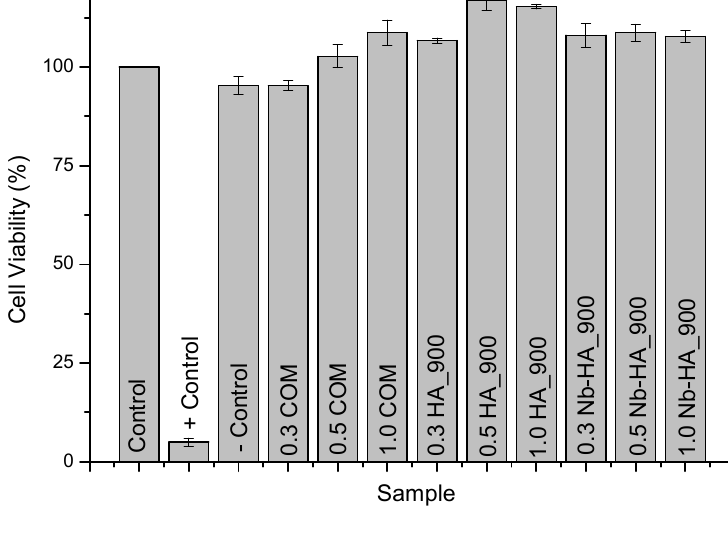
Figure 11. Results of cell viability assay by MTT after 72